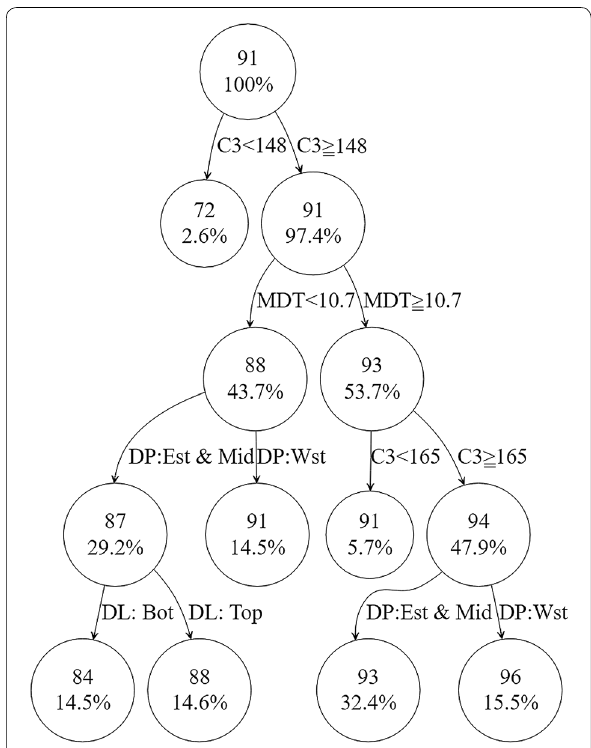
percentage of the